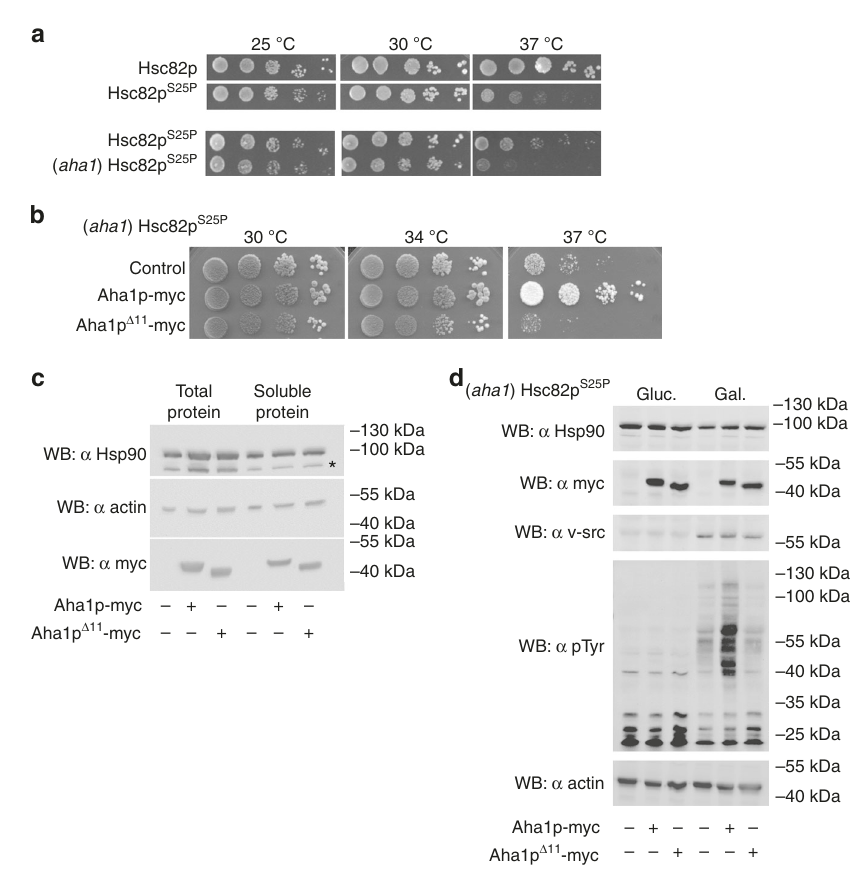
Fig. 5 The NxNNWHW motif is required for Aha1p function in vivo. a Yeast expressing Hsc82p S25P as the sole source of Hsp90 in the cell exhibit temperature-sensitive growth. The deletion of AHA1 in yeast expressing Hsc82p S25P exacerbates the temperature-sensitive growth defect. b Overexpression of myc-tagged Aha1p, but not Aha1p Δ 11 , rescues the growth of yeast expressing Hsc82p S25P . Yeast expressing Hsc82p S25P and